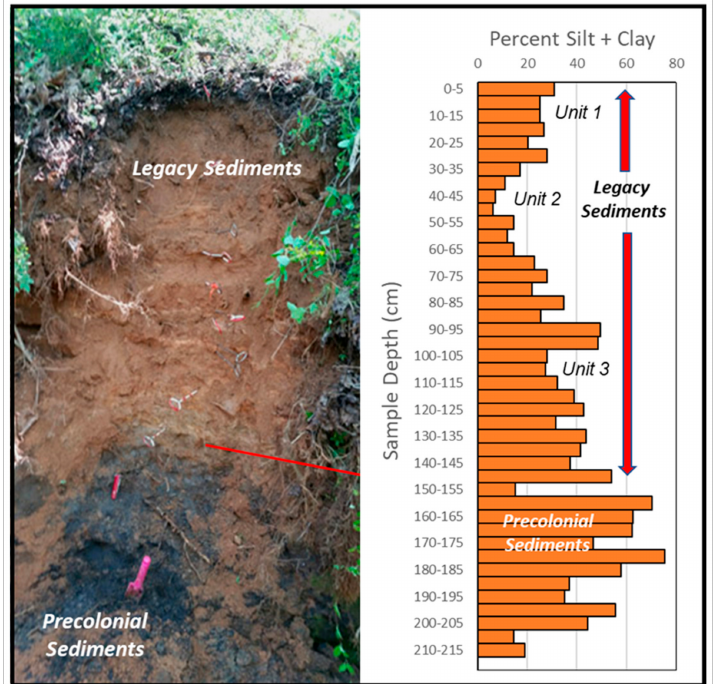
Figure 4. Variations in the percent of silt and clay in alluvial deposits described in the channel banks near the mouth of the Big Harris Creek project area (BHT3, Figure S1). Graph and photograph show the finer-grained, more indurated nature of the precolonial sediments, and occurrence of commonly observed sandy strata within the legacy sediments (figure from Miller et al.